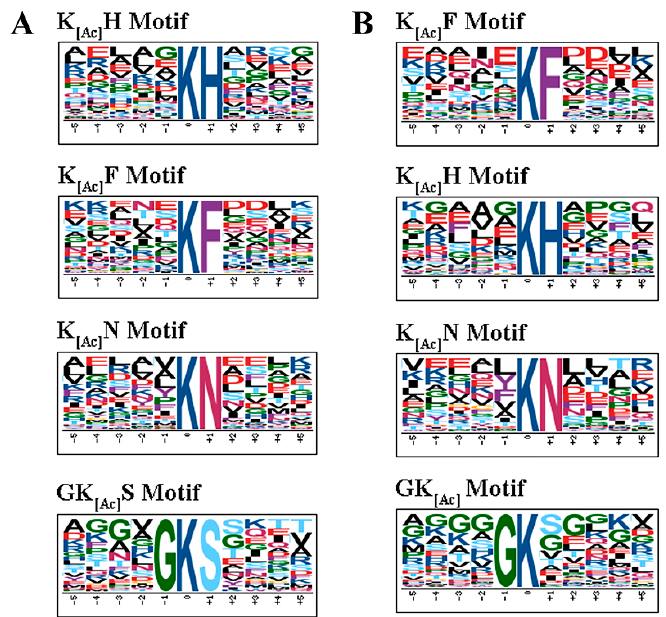
Figure 2. Motif analysis of all identified K Ac acetylated sites in RH strain and PYS strain. Sequence logo representation of significantly enriched acetylation site motifs for ± 5 amino acids around the lysine acetylation sites. ( A ) four motifs in RH strain, ( B ) four motifs in PYS strain.